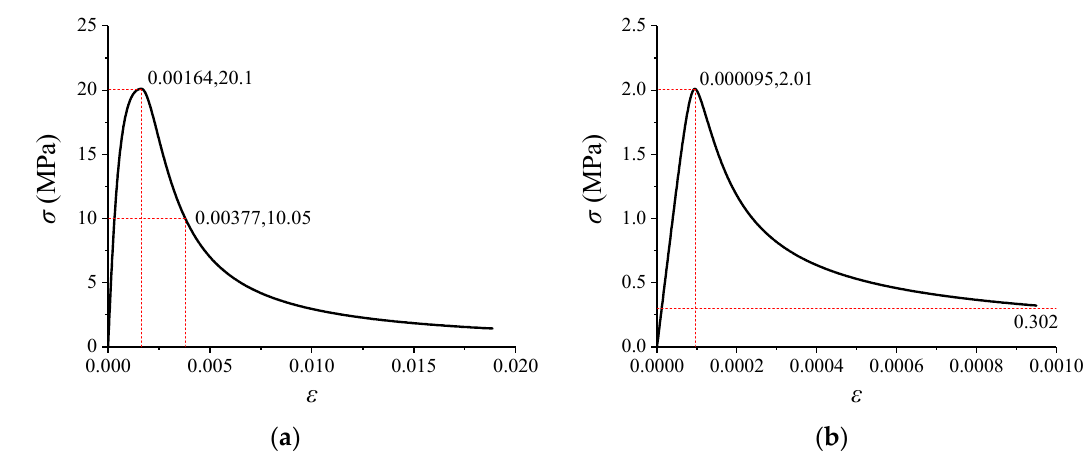
Figure 8. Uniaxial stress–strain relationship of the concrete. ( a ) Compression; ( b ) tension.